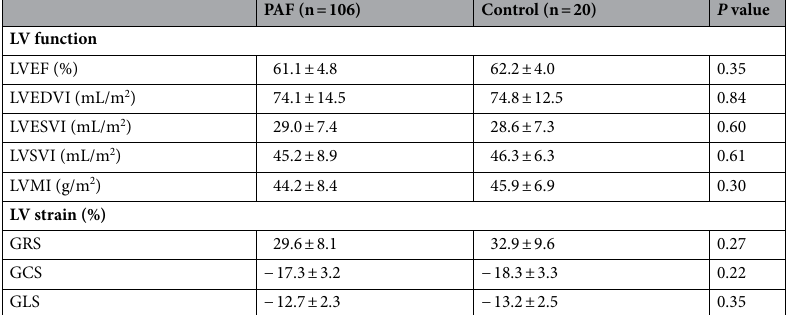
Table 2. Comparison of left ventricular function and strain between the PAF and control groups. All data are shown as mean ± standard deviation. GCS global circumferential strain, GLS global longitudinal strain, GRS global radial strain, LVEDVI left ventricular end diastolic volume index, LVEF left ventricular ejection fraction, LVESVI left ventricular end systolic volume index, LVMI left ventricular mass index, LVSVI left ventricular stroke volume